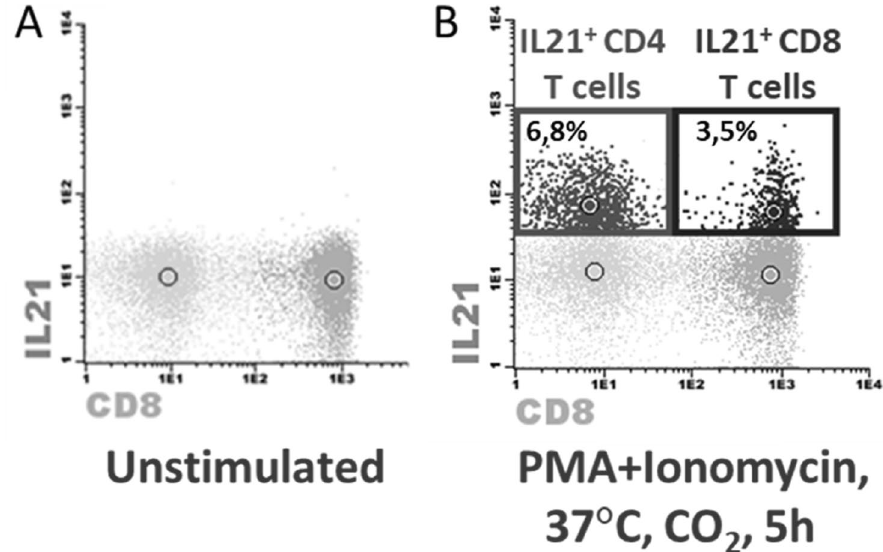
Figure 2. Gating Strategy for the identification of circulating CD4 and CD8 T-cells secreting IL-21 after stimulation. After identifying T-cells according to the expression of CD3 in the lymphocyte gate, CD4 T-cells were identified as the CD3 + CD8 − subset and CD8 T-cells as the CD3 + CD8 + . ( A ) Expression of IL-21 and